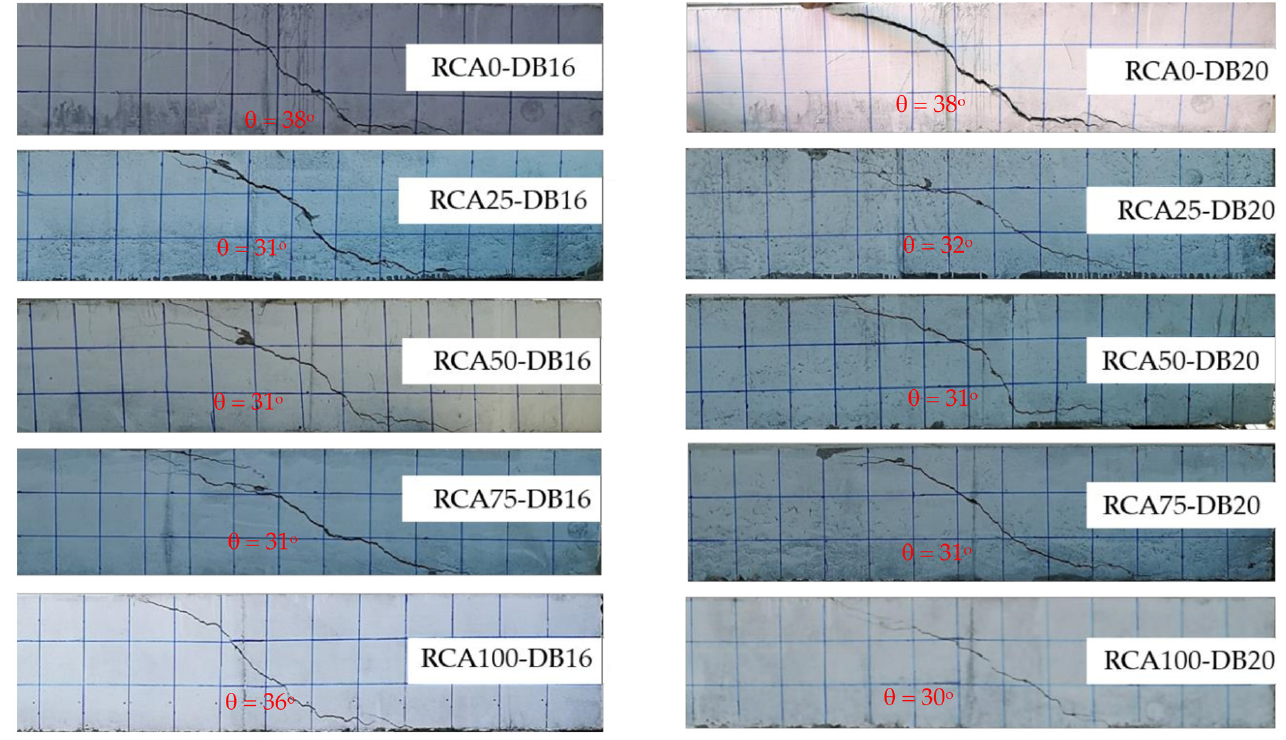
Figure 3. Failure of tested beams due to diagonal